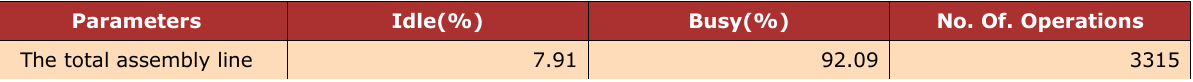
Table 9. The engine assembly line operation after the optimization of step